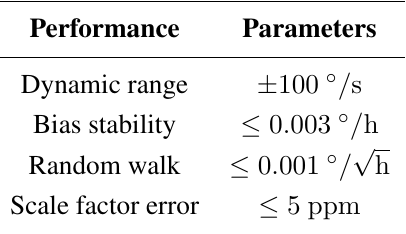
Table 8. The main parameters of the fiber optics gyroscope.